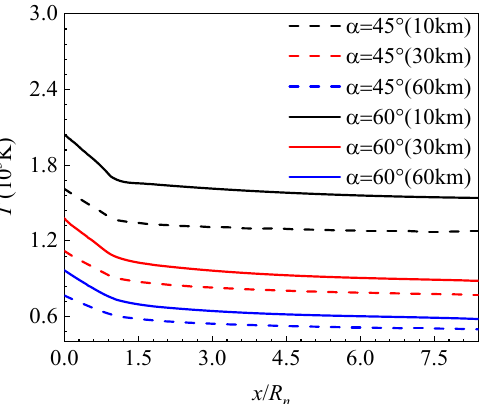
Figure 13. Surface temperature profiles of blunt body for representative cases.